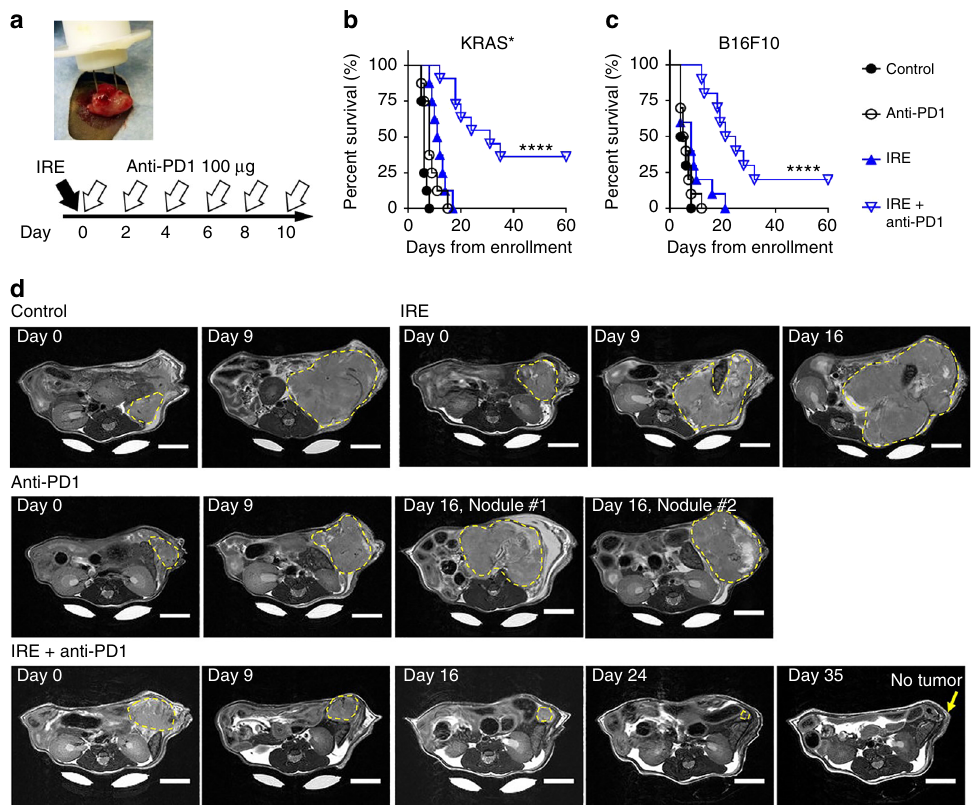
Fig. 1 Animal survival after treatment with IRE and/or anti-PD1. a Treatment schedule and a photograph showing the placement of the two-electrode IRE array in the KRAS* tumor. C57BL/6 mice bearing orthotopic KRAS* tumors were enrolled for treatment once tumor size reached about 7 mm in one dimension. Sham surgery was performed on both control and anti-PD1 treatment groups. b Kaplan – Meier survival analysis of mice with KRAS* tumor treated with sham control (black solid circle, n = 8), IRE (black circle, n = 8), anti-PD1 (blue solid triangle, n = 8), or IRE + anti-PD1 (blue triangle, n = 11). **** p < 0.0001, log-rank test. c Survival analysis of B16F10-bearing mice treated with sham control ( n = 10), IRE ( n = 10), anti-PD1 ( n = 10), or IRE + anti- PD1 ( n = 10). **** p < 0.0001, log-rank test. d Representative axial T 2 -MRI images of a KRAS*-bearing mouse from each group in a separate small-scale study. Three mice per group were enrolled in the sham control, anti-PD1, and IRE groups; 5 mice were enrolled in the IRE + anti-PD1 group. Treatment started on day 0. MRI slices with the largest tumor cross-section are presented to show tumor size at each time point. The entire extent of the tumor is outlined with yellow dashed lines. MRI images were acquired weekly until the mice were euthanized due to excessive tumor burden. The surviving mice in the IRE + anti-PD1 group were imaged until day 42 (Supplementary Figure 6). Scale bar = 5 mm. Source data are provided as a Source Data fi le